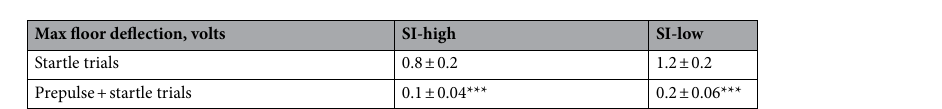
Table 3. The prepulse sound attenuated the ASR at both low and high arousal levels. ***p < 0.001 for comparisons between different trial types (Wilcoxon signed-rank test).